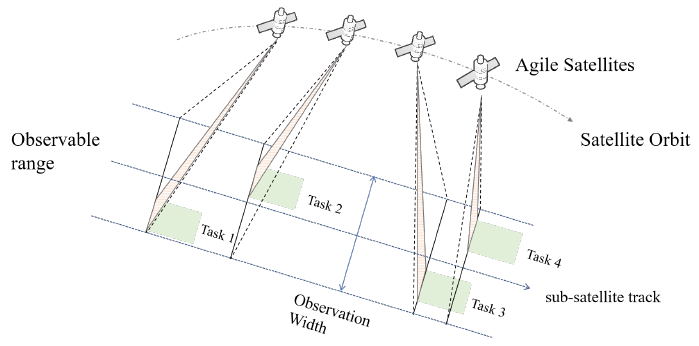
Figure 1. Diagram of agile satellite performing observation